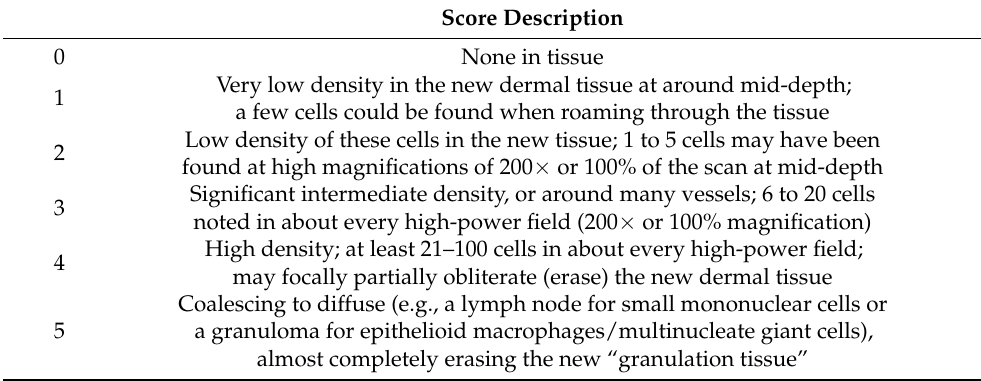
Table 1. Scoring for density of inflammatory